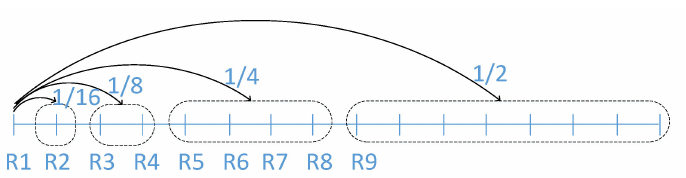
Figure 9. The threshold of migration